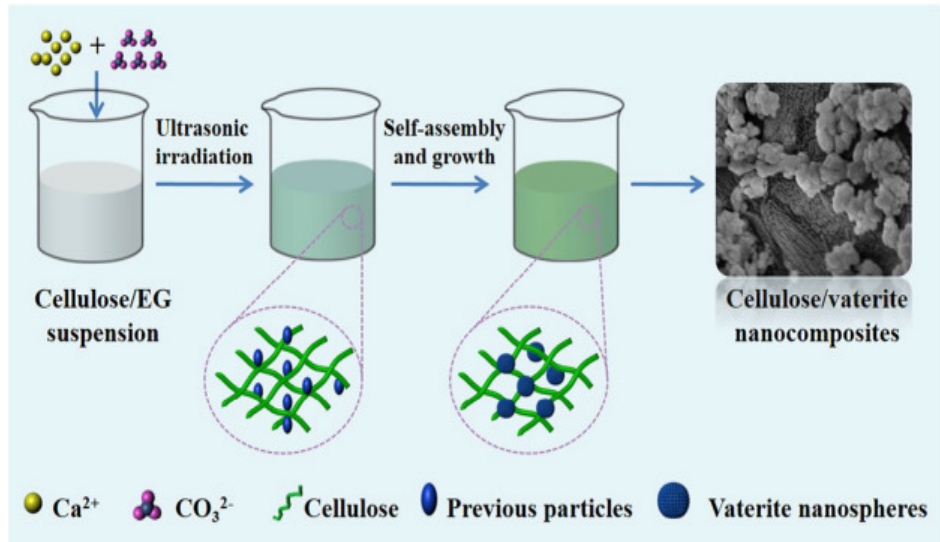
Figure 3. Design for the formulation of cellulose/vaterite nanocomposites by the sono-chemical method. Adapted with permission from [17].